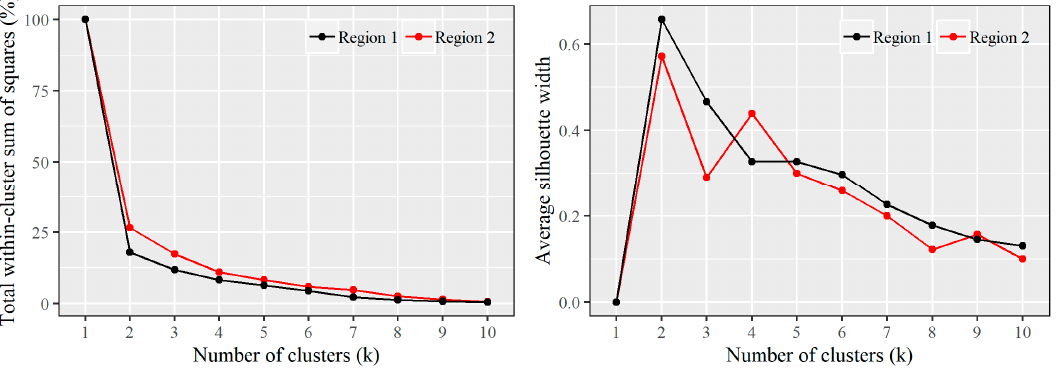
Figure 6. Total within-cluster sum of squares and average silhouette width versus the number of clusters (k) of months while considering their meteorological characteristics for two different regions.